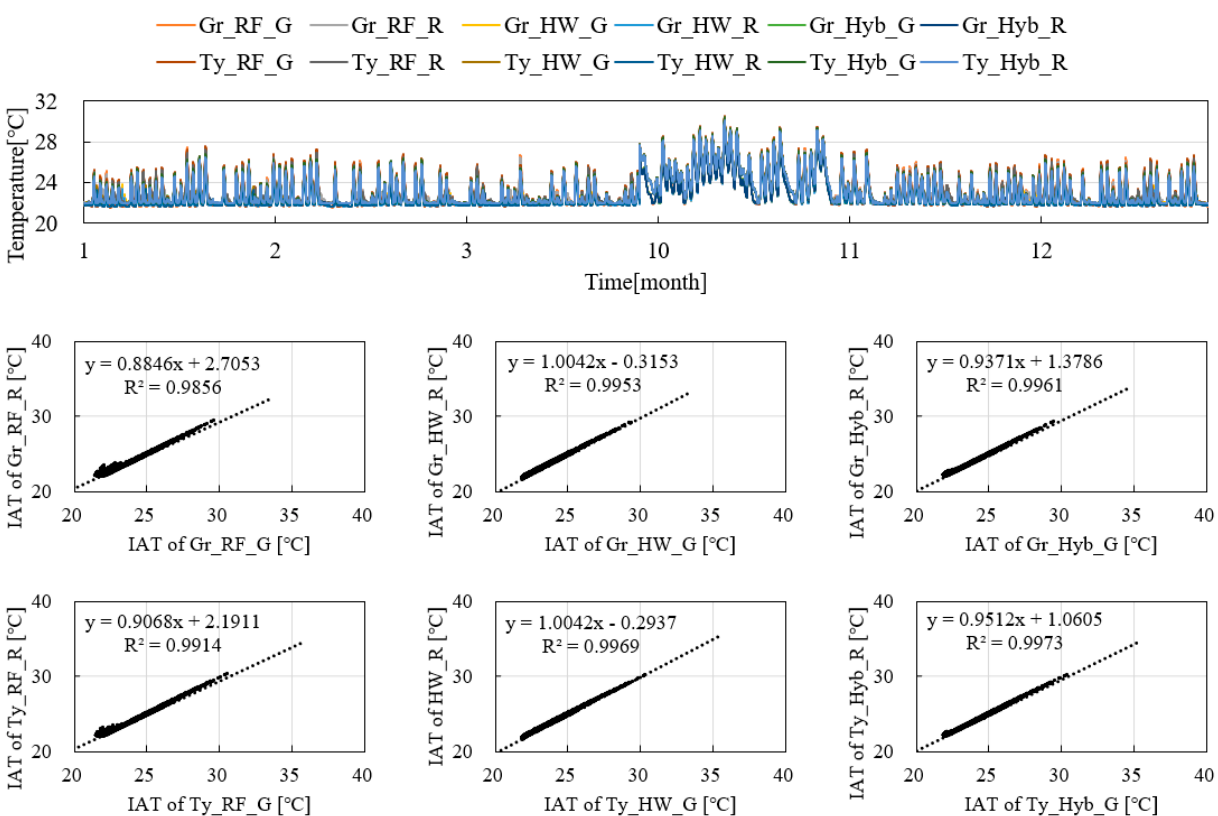
Figure 5. Outdoor air temperature (OAT) and indoor air temperature (IAT) of the glass zone (G) and room zone (R) of simulation models according to the floor boundary condition (ground floor: Gr, typical floor: Ty) and heating system.